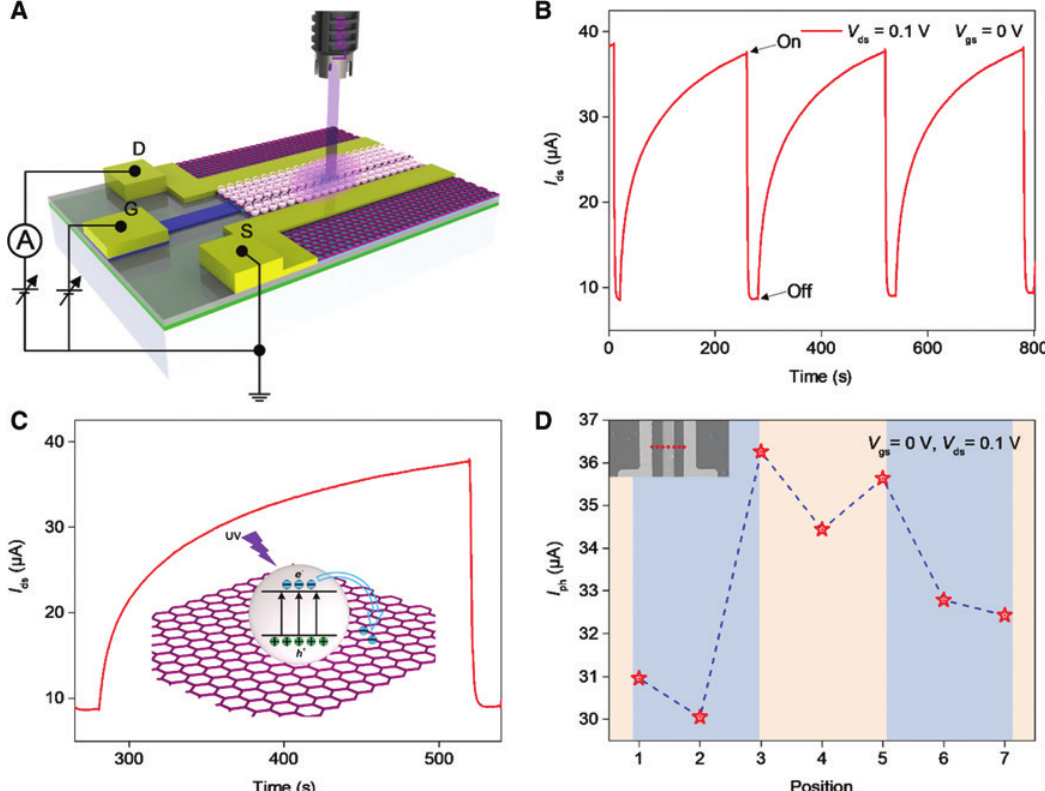
NPs decorated 2